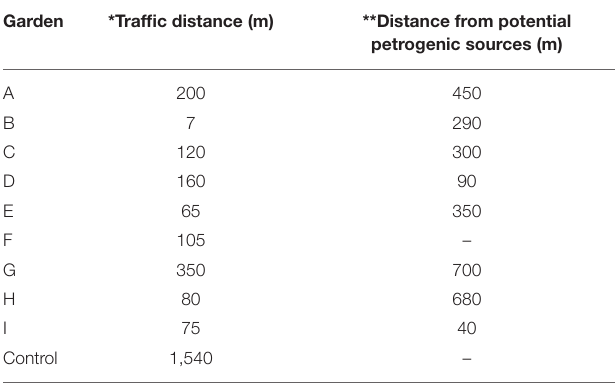
TABLE 1 | Distance of UCGs and traffic/petrogenic sources.